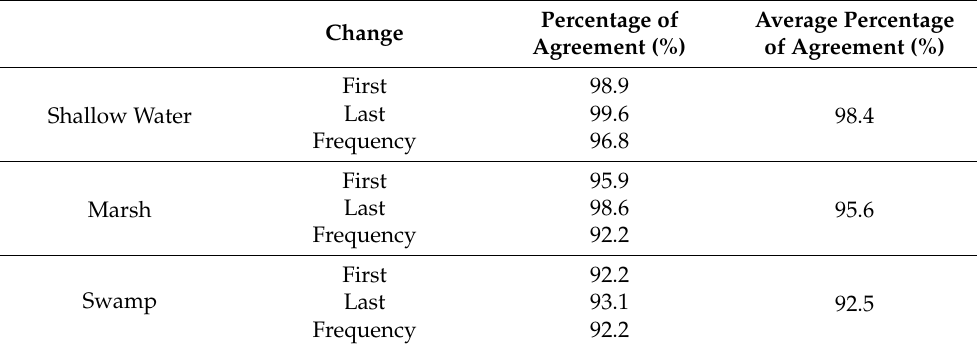
Table 7. Percentage of Agreement between the Multitemporal Change Detection Results of FP and CP SAR (adapted from